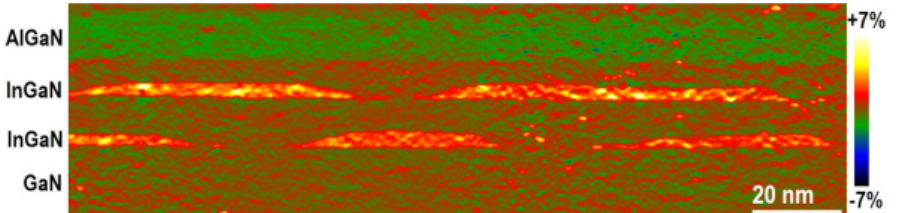
Figure 1. The two-dimensional image of the out-of-plane strain obtained by geometric phase analysis of the HRTEM image used to derive the three-dimensional